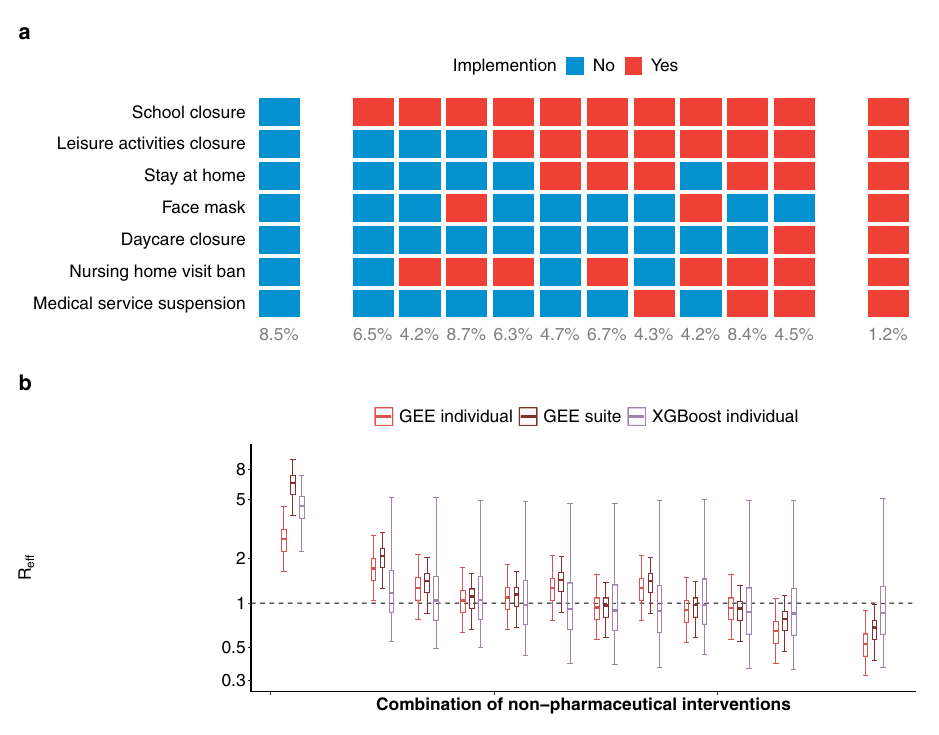
Fig. 4 Prediction of reproduction numbers ( R eff ) associated with different non-pharmaceutical interventions (NPIs) suites. a Non-pharmaceutical interventions (NPIs) suites: no intervention (left column), all interventions (right column) and the ten most frequently used NPI suites in counties in the United States (middle columns; ordered by number of NPIs implemented (red; otherwise, blue) in each suite). Numbers below the columns are percentages of county-weeks in the study in which the suites were active. b R eff with different NPI suites ( n = 34,778 county-weeks). Median (cross), interquartile range (boxes) and 95% quantile range (vertical lines) of R eff were distributions of predictions from the main model fi tted with generalized estimation equations (GEEs, red, Fig. 3a), GEEs with NPIs fi tted as suites (brown), and boosted decision tree (XGBoost individual, purple). X -axes are NPI suites that were shown in a . Horizontal dashed line indicates the threshold of one. Data are presented as median, interquartile, and 95%